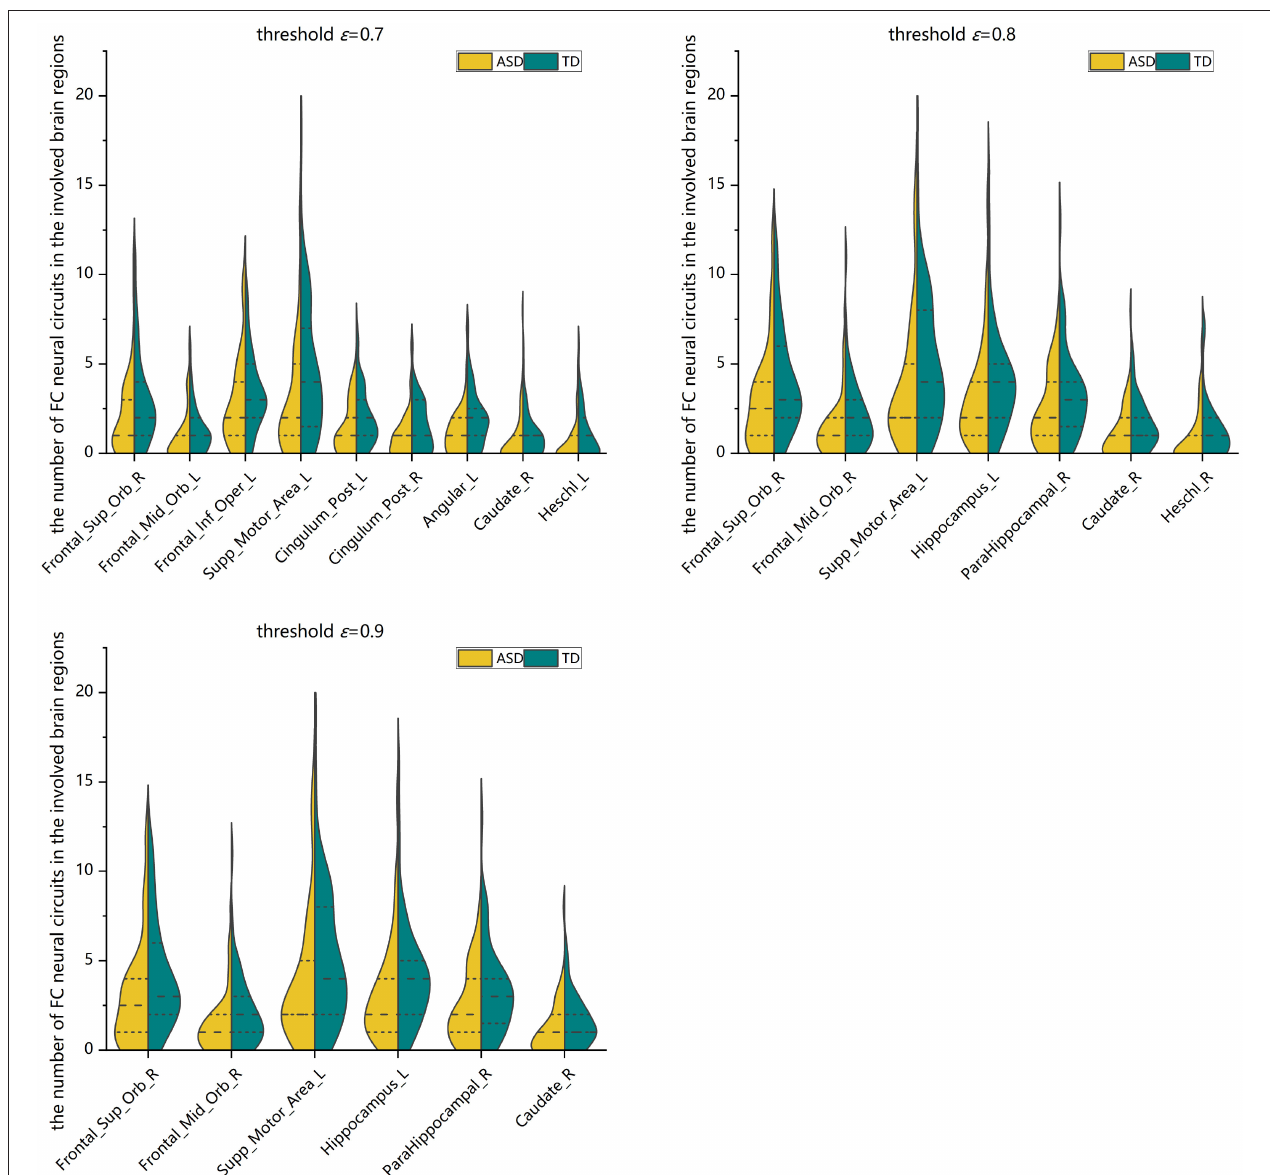
FIGURE 8 | Violin pictures of the comparison of the numbers of FC neural circuits in significantly different brain regions involved in the two